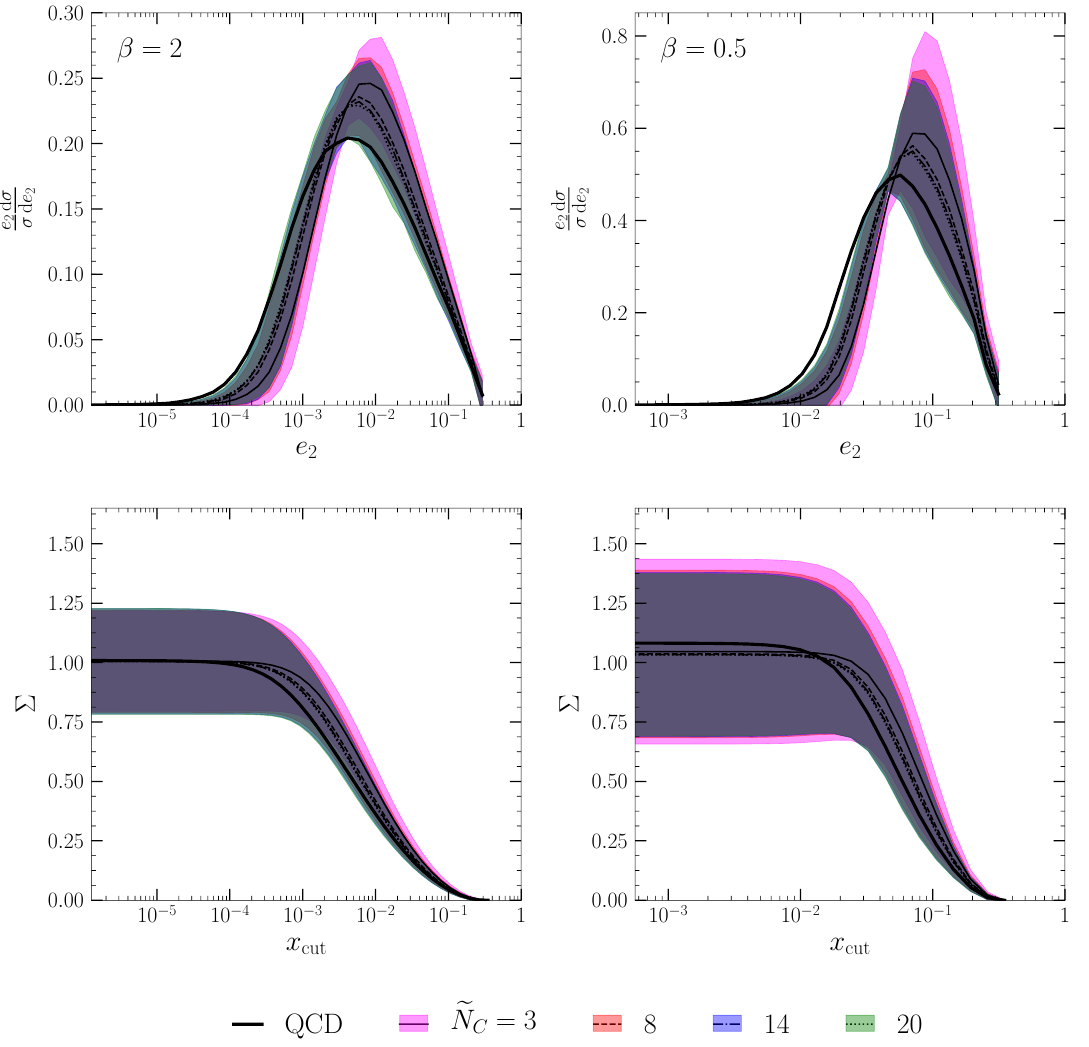
Figure 5 . The behavior of e 2 as the dark sector gauge group SU( e N C ) is varied, for p T = 1 TeV jets. See the legend for values of e N C ; all other values are given in table 1. We show the normalized e 2 distributions [top], where the central value of the envelope is marked with the black lines, while the shaded region denotes the envelope. The peak moves to slightly lower values of e 2 as e N C is increased. The cumulant distributions (cid:6) as a function of x cut are also provided [bottom], where again the lines denote the central values and the shaded bands are the integrated envelopes, see eq. (2.9). We show both results for two choices of the angular dependence: (cid:12) = 2 [left] and (cid:12) = 0 : 5 [right].